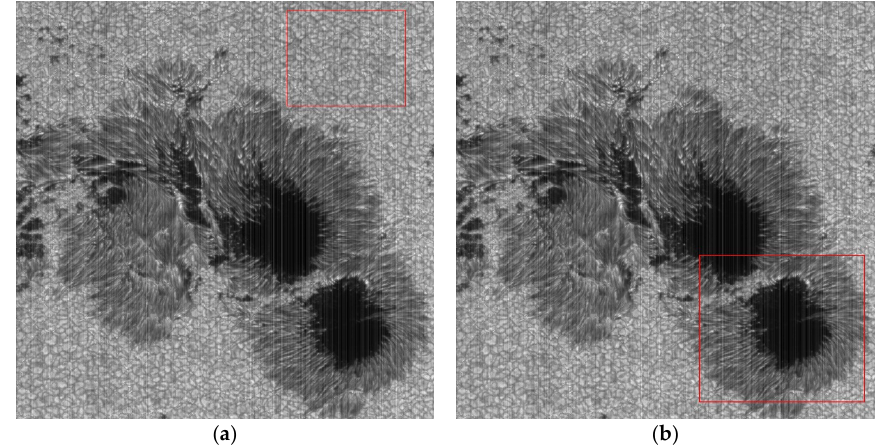
Figure 16. Photo of sunspots in the solar TiO band. ( a ) Emphasis area is granular areas; ( b ) emphasis area is sunspot.